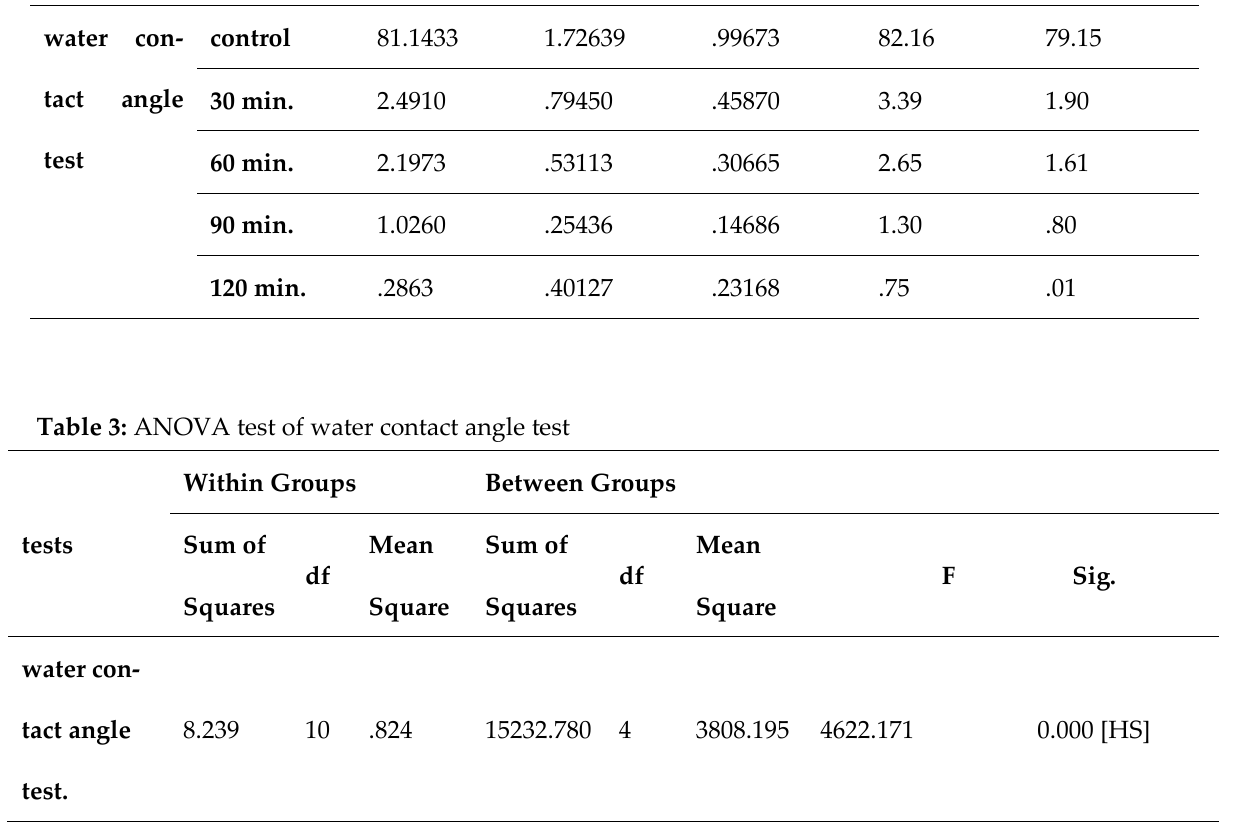
the results of the bond strength testing for each coating type. The maximum adhesion strength of SR HA layer deposited on a PEKK was 2.59 MPa. (standard range 0.4 -3.3 MPa ) was found 120 min. deposi- tion time for SR HA coatings